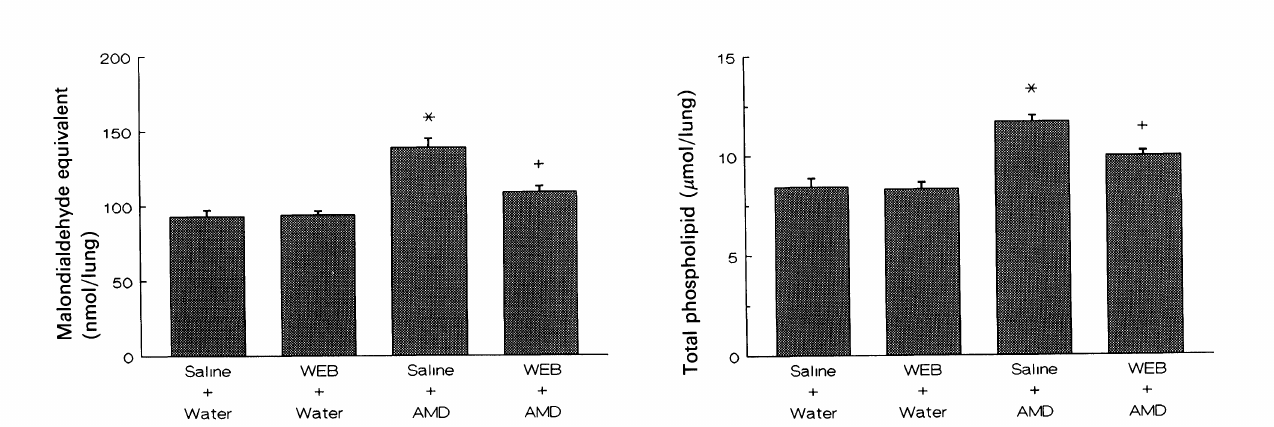
FIG. 4. Effects of WEB 2086 on amiodarone (AMD) induced increases in malondialdehyde equivalent level in hamster lung. See the legend to Fig. for treatment details. Each value represents the mean hamsters in each group. Significantly higher (p < 0.05) than all other groups, t Significantly higher (p _< 0.05) than saline + water and WEB -t- water groups.